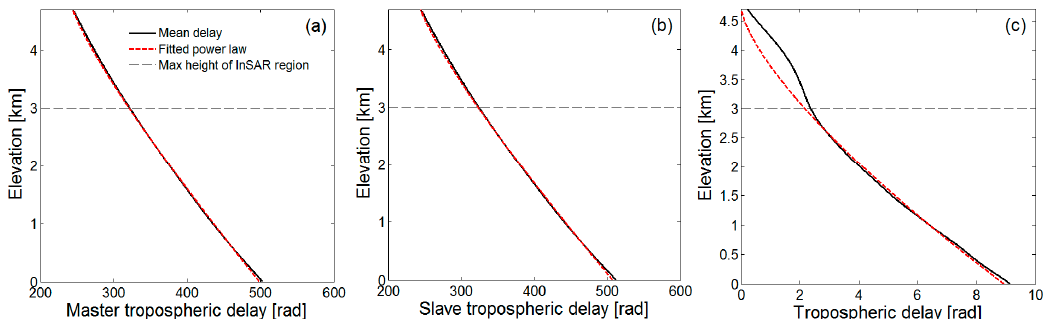
Figure 3. Mean delay and fitted power law with respect to the elevation. The black solid line represents the corresponding phase delay calculated from the ERA-I data at six grid points (18:00 UTC) on interferogram 20090627/20090905 in California. The points are shown within the green rectangle in Figure 2a. The red dashed line shows the best fit line using the power law model. The black dashed line indicates the maximum height of the InSAR region. ( a , b ) The tropospheric delays for the master and slave acquisitions show a near power law function with α being 1.18 and 1.19. The delay offset at the height of 4.7 km was added back after a log-log linear estimation. ( c ) The relative tropospheric delay shows a power law relationship ( 1.39).